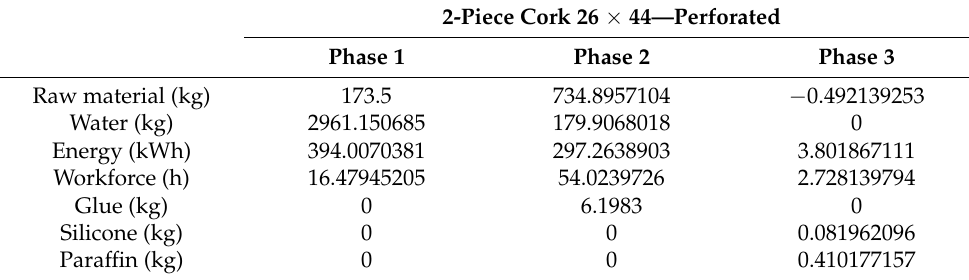
Table 2. Consumption for 1000 kg raw material used to produce 2-piece stoppers with dimensions 26 × 44—Drilled (Perforated)